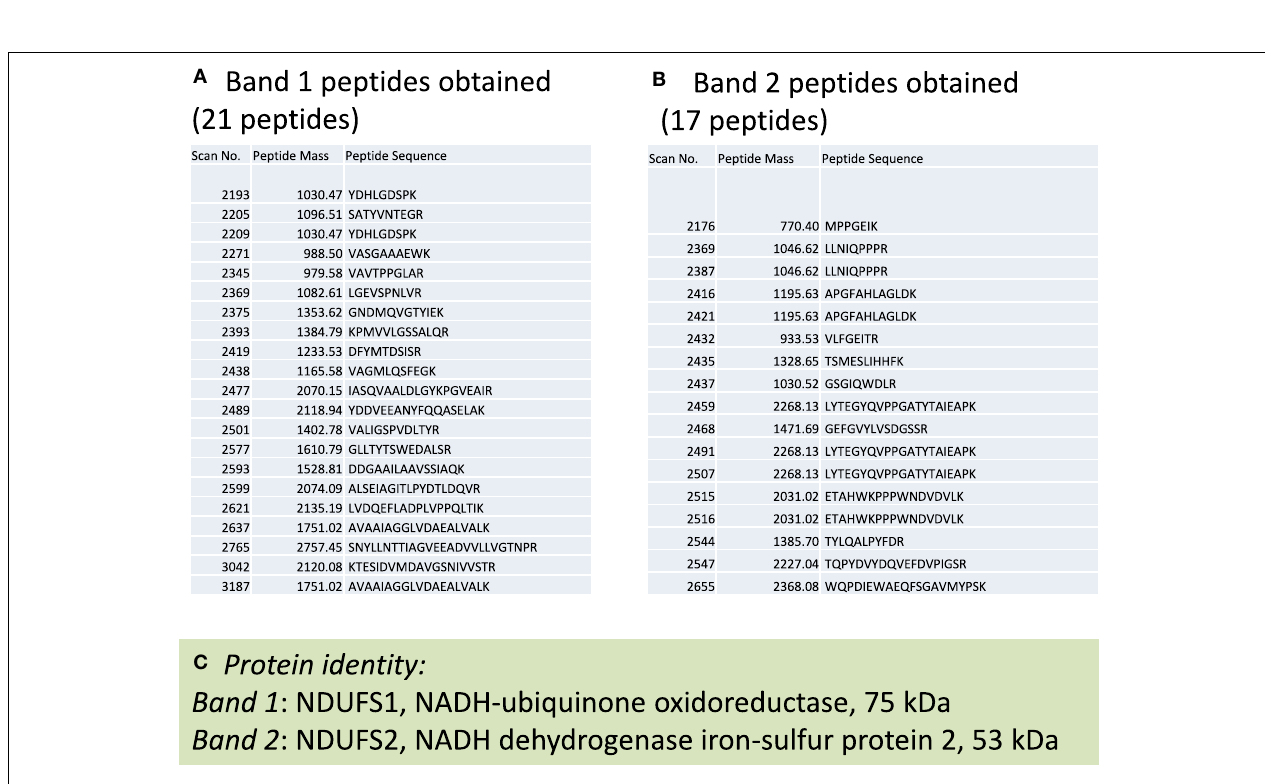
FIGURE 6 | Mass spectrometric peptide sequencing of band 1 and band 2. Shown are (A) 21 peptides that matched to NDUFS1, (B) 17 peptides that matched NDUFS2, and (C) the identity of each protein indicated in Figure 5A .